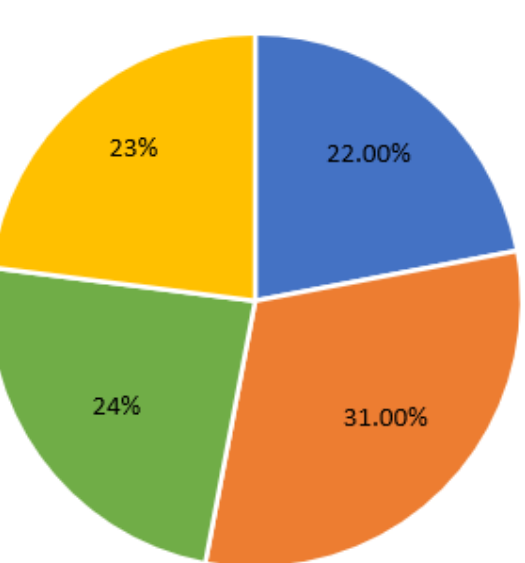
Figure 2. Teleworker geographical distribution within V4 countries. In total, 47.75% of respondents were females and 52.25% were males (202 female, 221 male); see Figure 3.